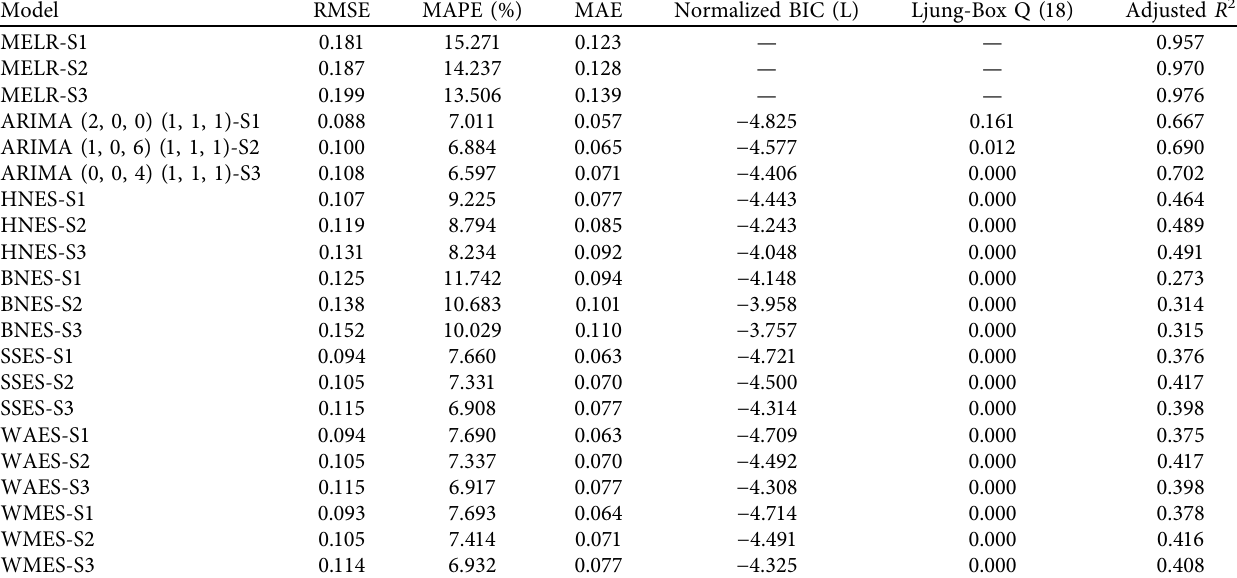
Table 4: The comparison of passenger volume prediction in MELR and time series